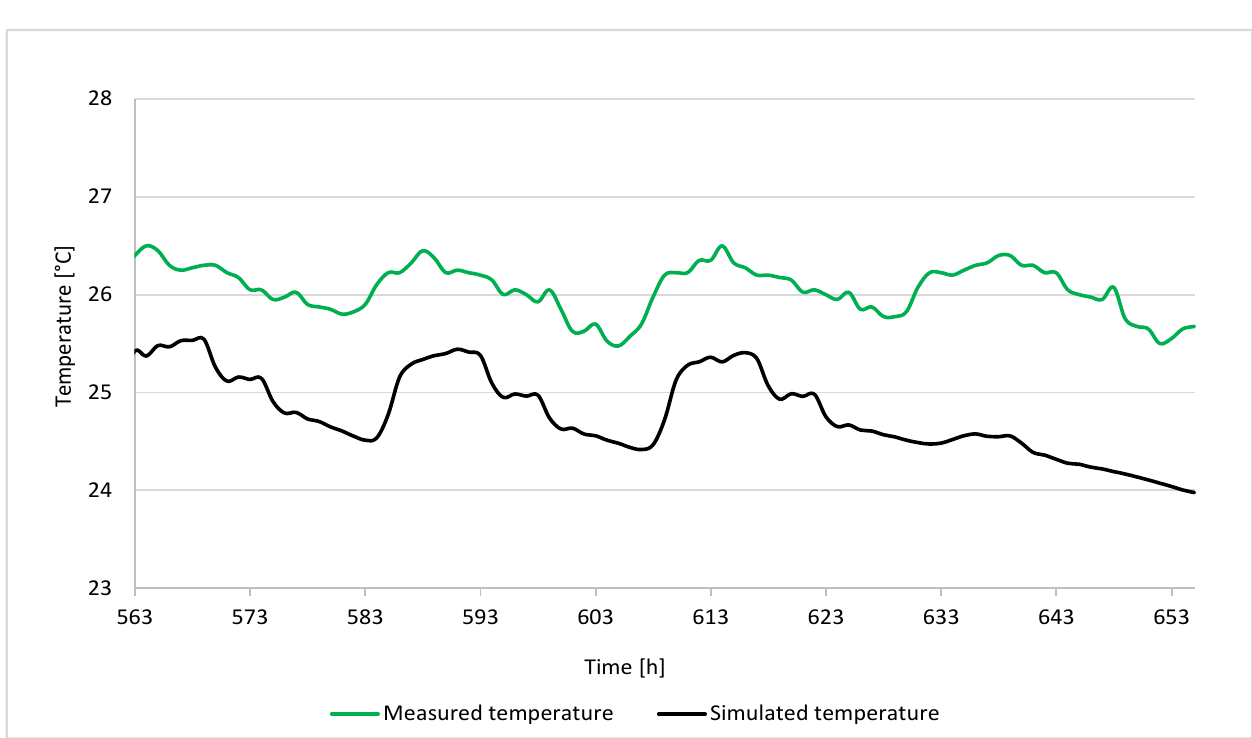
Figure 7. Illustrative comparison between experimental (green solid line) and predicted air temperature inside the studied space (black solid line).